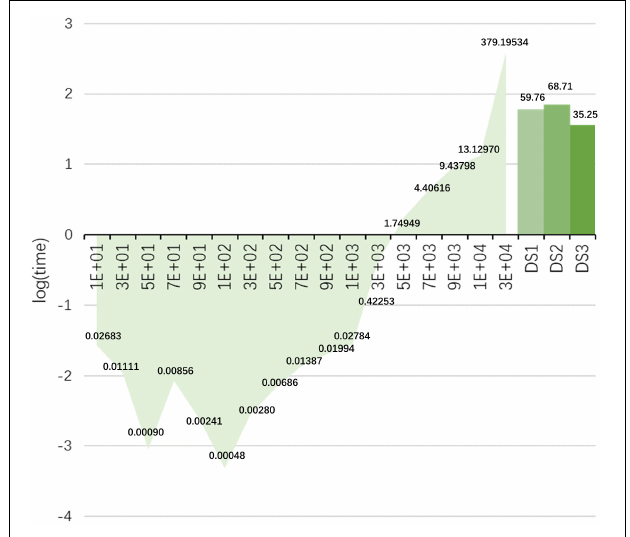
FIGURE 7 | Changes in the run-time (s) of matrix inversion when the size of the matrix increases. In the left part, the horizontal axis represents the size of the square array. The vertical axis is the value after taking the logarithm of the time. The bar chart represents the average time cost of the proposed method on the three